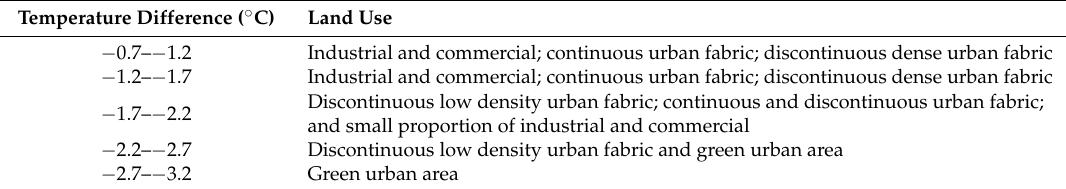
Table 6. Temperature difference (LST—T air ) at 1:30 and Land use